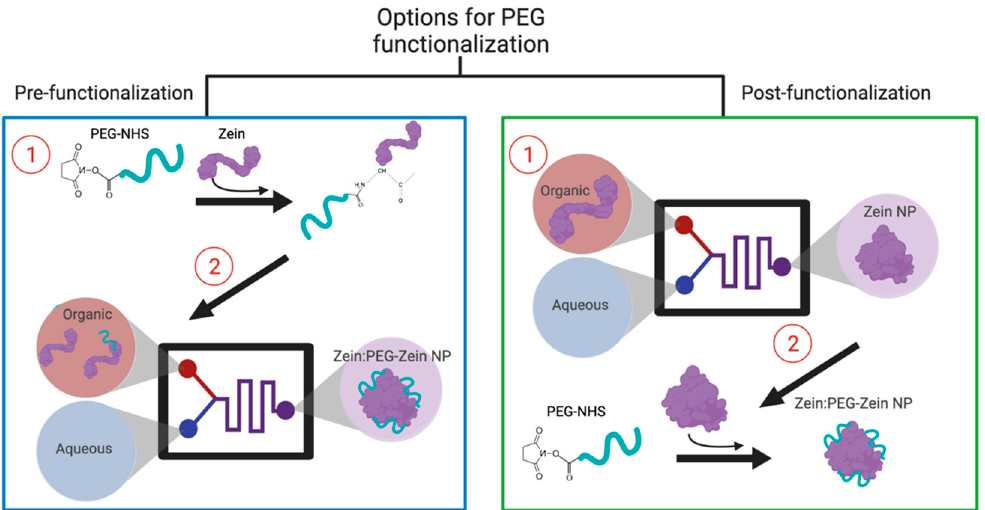
Figure 2. Illustration of the polyethylene glycol (PEG) conjugation methods (pre- and post-functionalization of Zein and Zein nanoparticles (NP)s, respectively) that could be utilized for PEGylation of Zein via a PEG-N-hydroxysuccinimide (NHS) ester reaction.